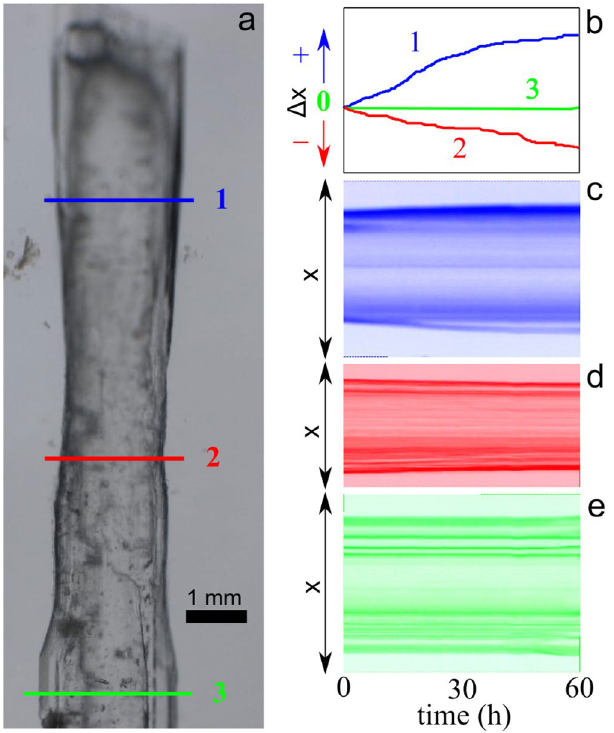
Figure 6. Natural brine mixing experiment. ( a ) Gypsum crystal after 60 h of stable halocline flow using natural brines from the top and bottom of the eastern pond. ( b ) Plot of the growth of the crystal at level 1, dissolution at level 2, and equilibrium at level 3. ( c ) Time-sliced image of 1, ( d ) time-sliced image of 2, ( e ) time-sliced image of 3. The original video can be found in Supplementary Video